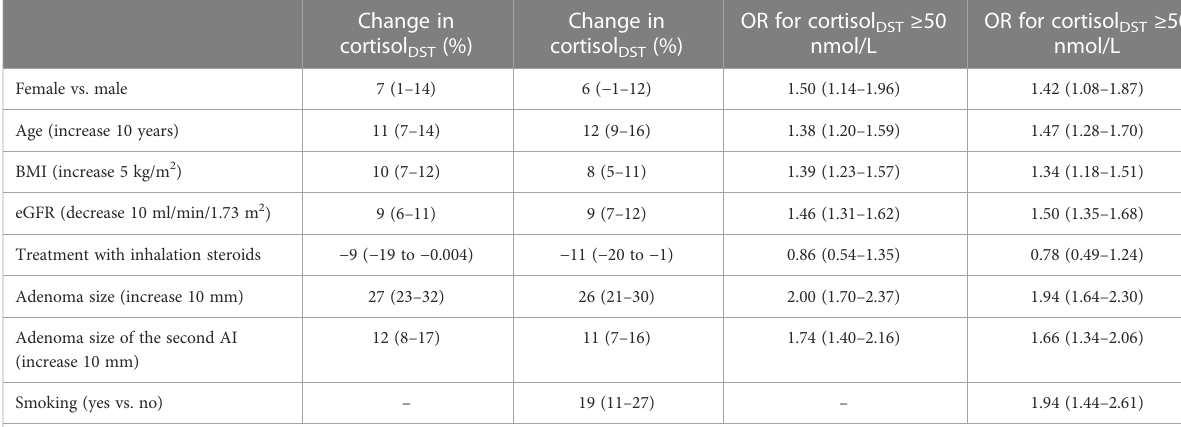
TABLE 3 Associations to cortisol DST and cortisol DST to be ≥ 50 nmol/L in the whole cohort.